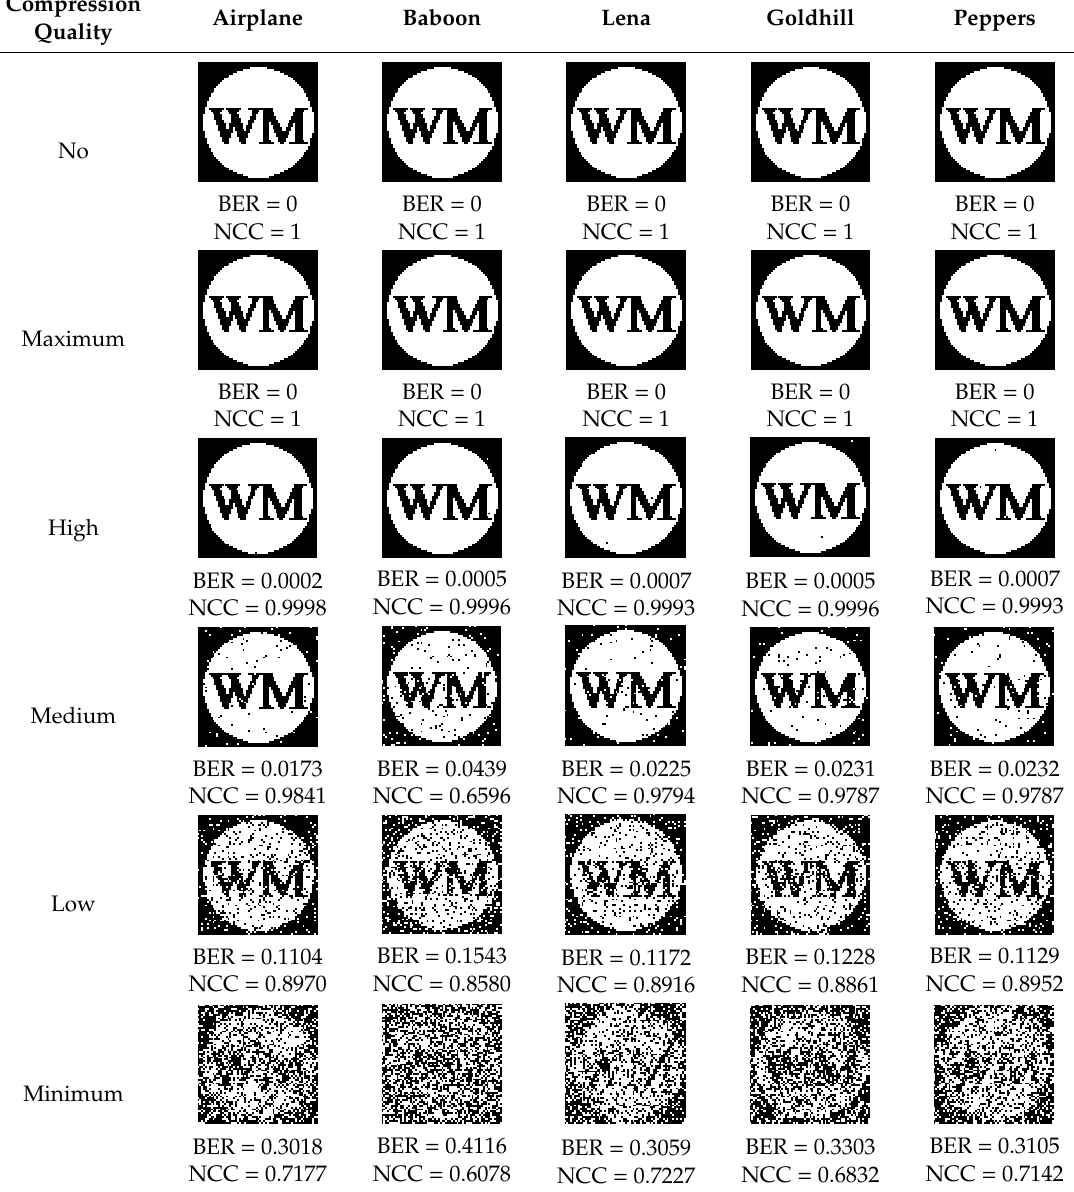
Table 3. Watermarks extracted from poorly detailed synthesized watermarked images obtained by the algorithm in [31].